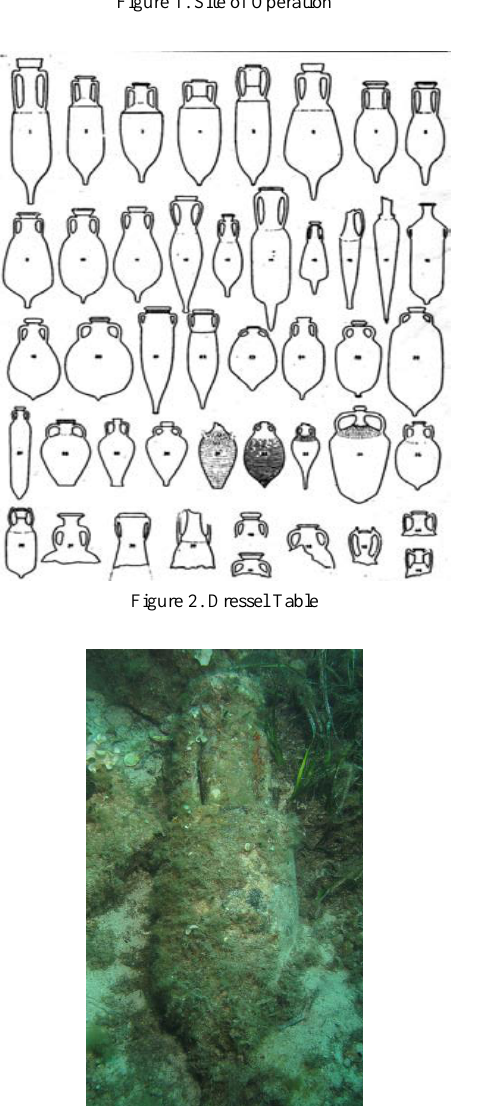
Figure 3. Amphora Dressel B1 on the seabed